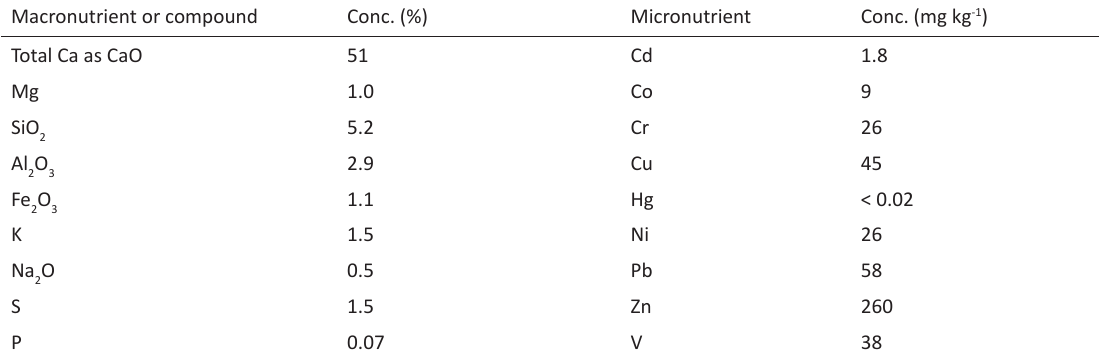
Table 2. Chemical composition (dry matter basis) of the structure lime product Nordkalk Aktiv Struktur (approximately 80–85% ground limestone and 15–20% slaked lime) spread in field trials in August–September 2014. Water content 15–25% depending on storage. Particle size 0–0.5 mm with 99% passing through mesh size 0.5 mm. Source: Nordkalk Corp.